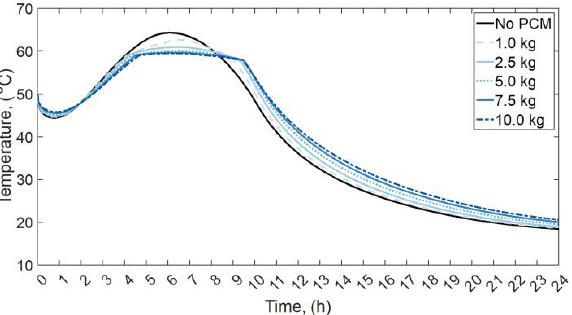
Figure 14. Water temperature in the SS with different masses of PCM — Case 2.